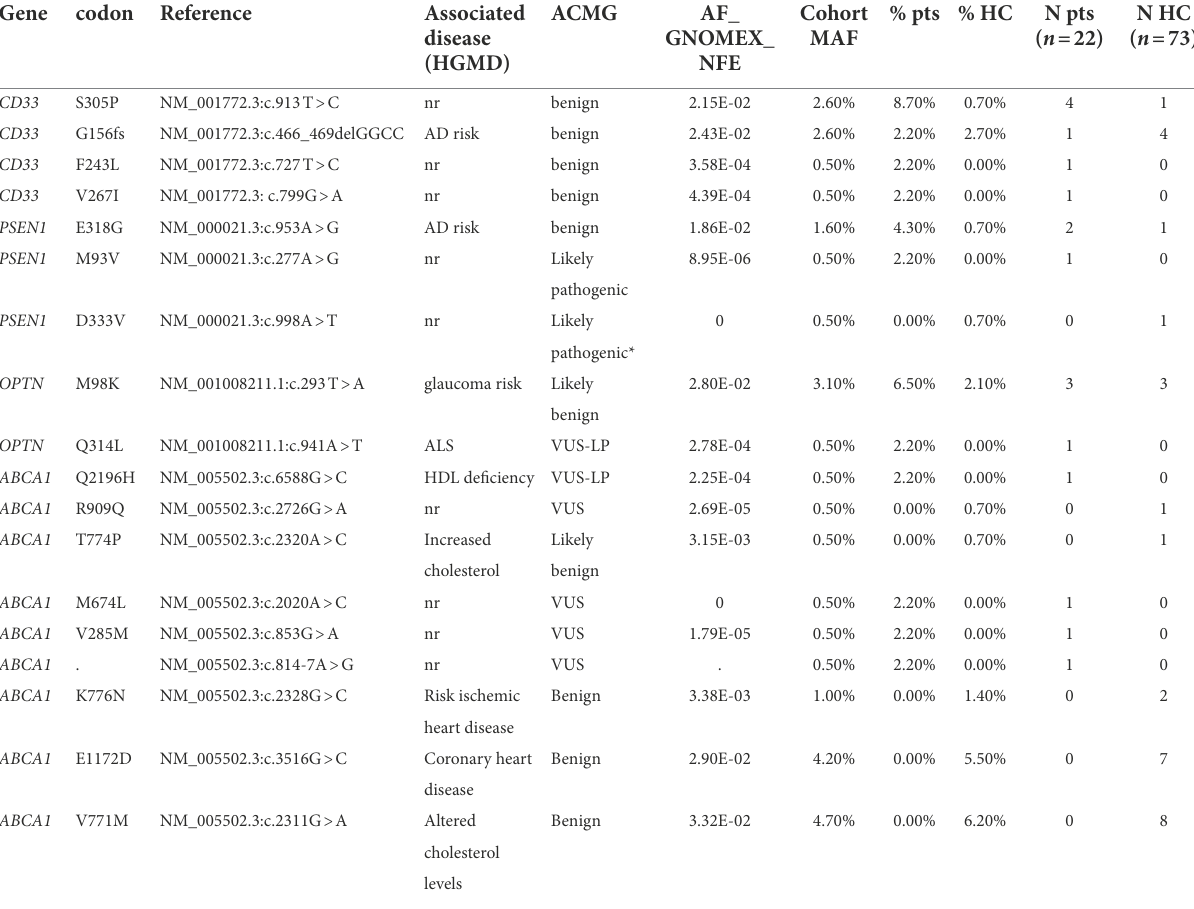
TABLE 5 Variants present in the enriched genes (gene-based aggregation analysis).